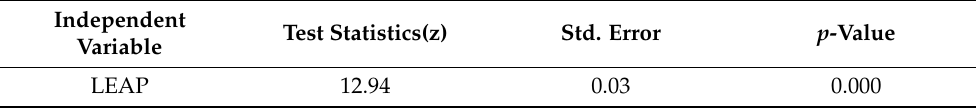
Table 7. Sobel Test of